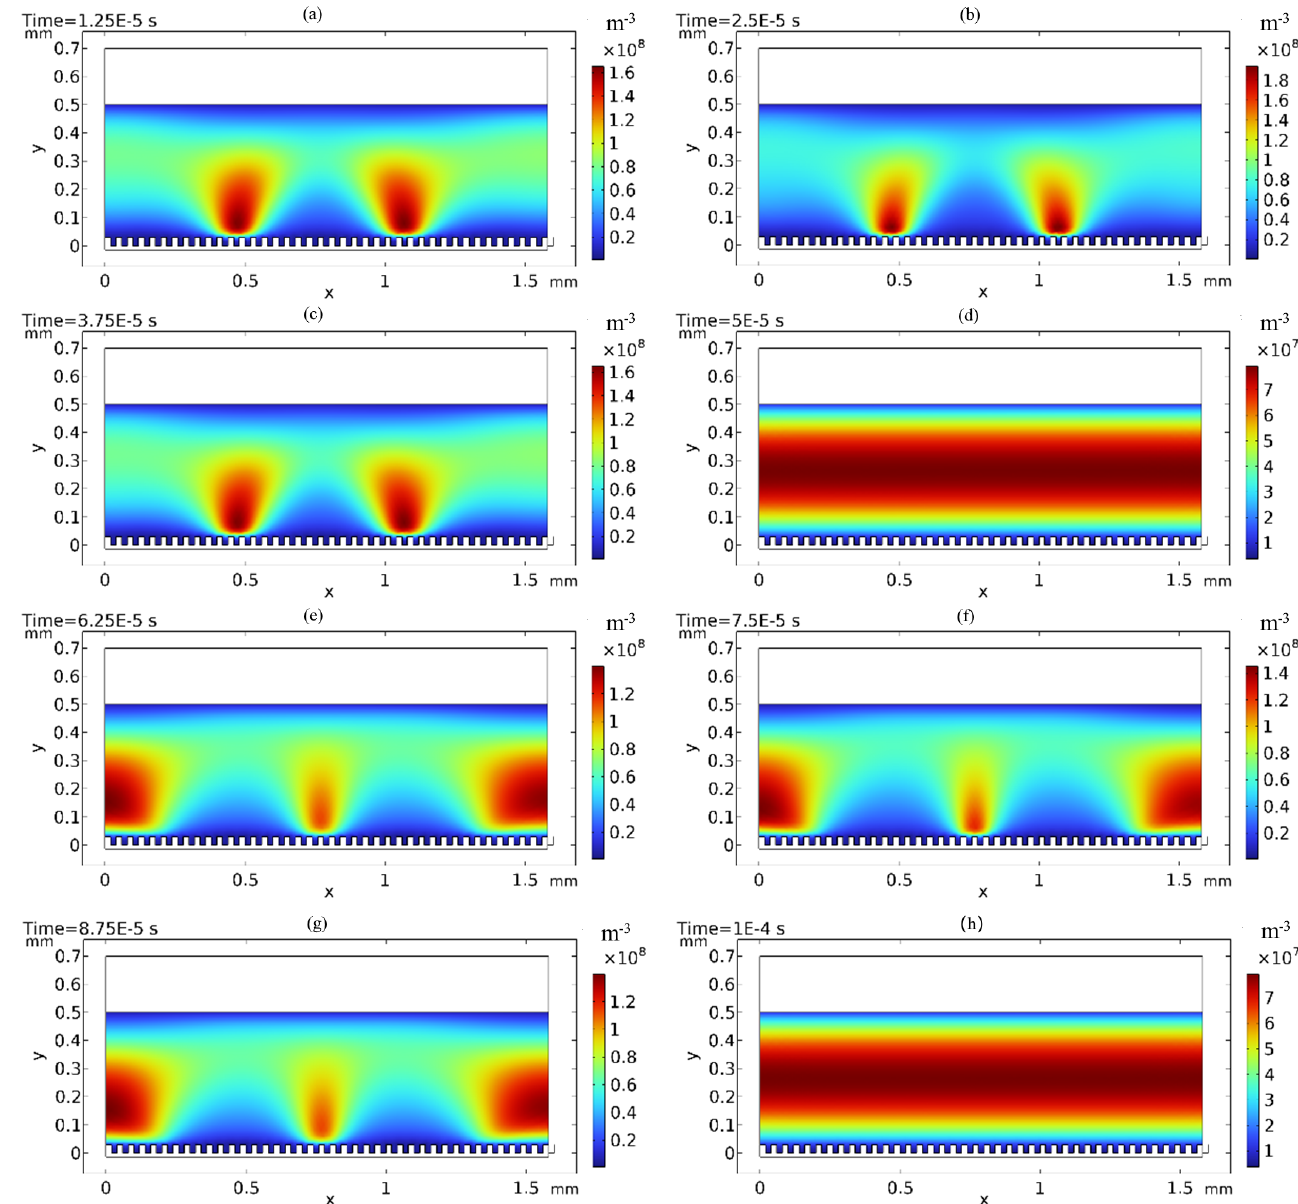
Figure 10. Evolution of the electron density in the coplanar CPED device. ( a ) 1/8 T, ( b ) 1/4 T, ( c ) 3/8 T, ( d ) 1/2 T, ( e ) 5/8 T, ( f ) 3/4 T, ( g ) 7/8 T, ( h ) 1 T.